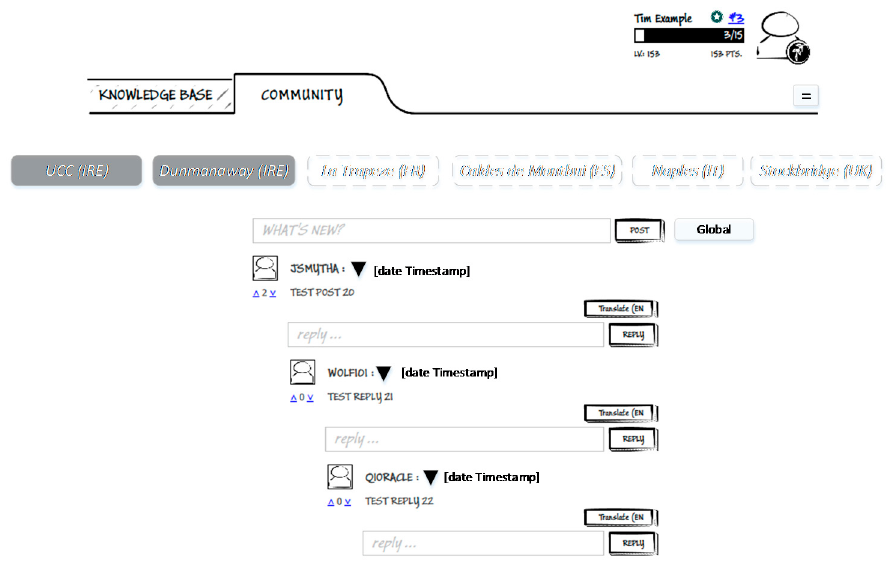
Figure 3. User platform–Community feed (registered user view, filtered for Ireland